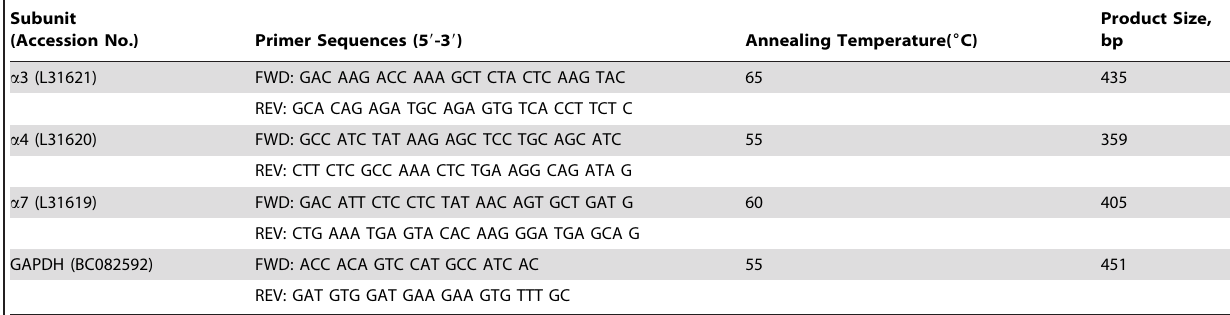
Table 1. PCR primer sequences.